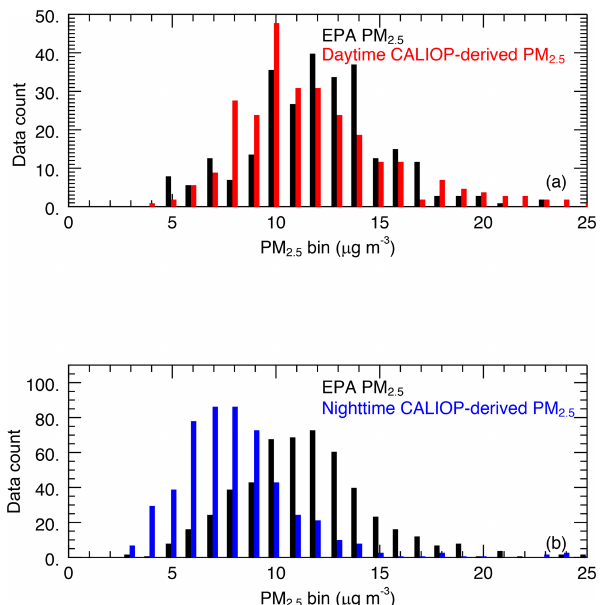
Figure 7. The 2-year (2008–2009) histograms of mean PM 2 . 5 con- centrations from the U.S. EPA and those derived from spatially and temporally collocated aerosol extinction using (a) daytime and (b) nighttime CALIOP data.